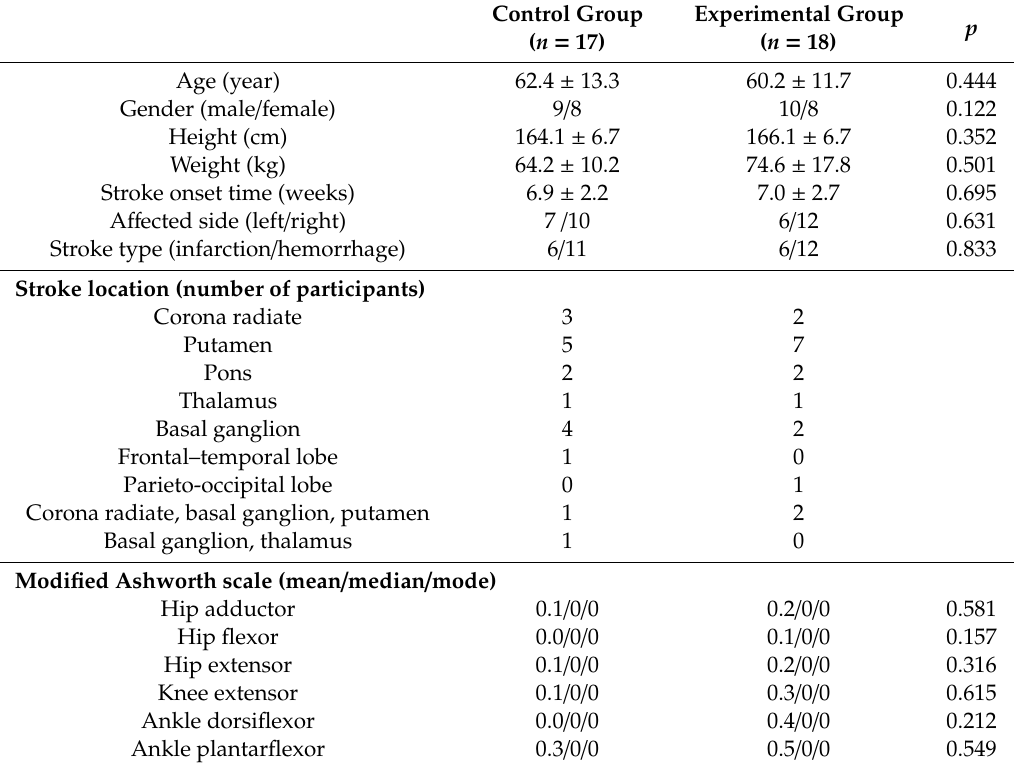
Table 2. Participant